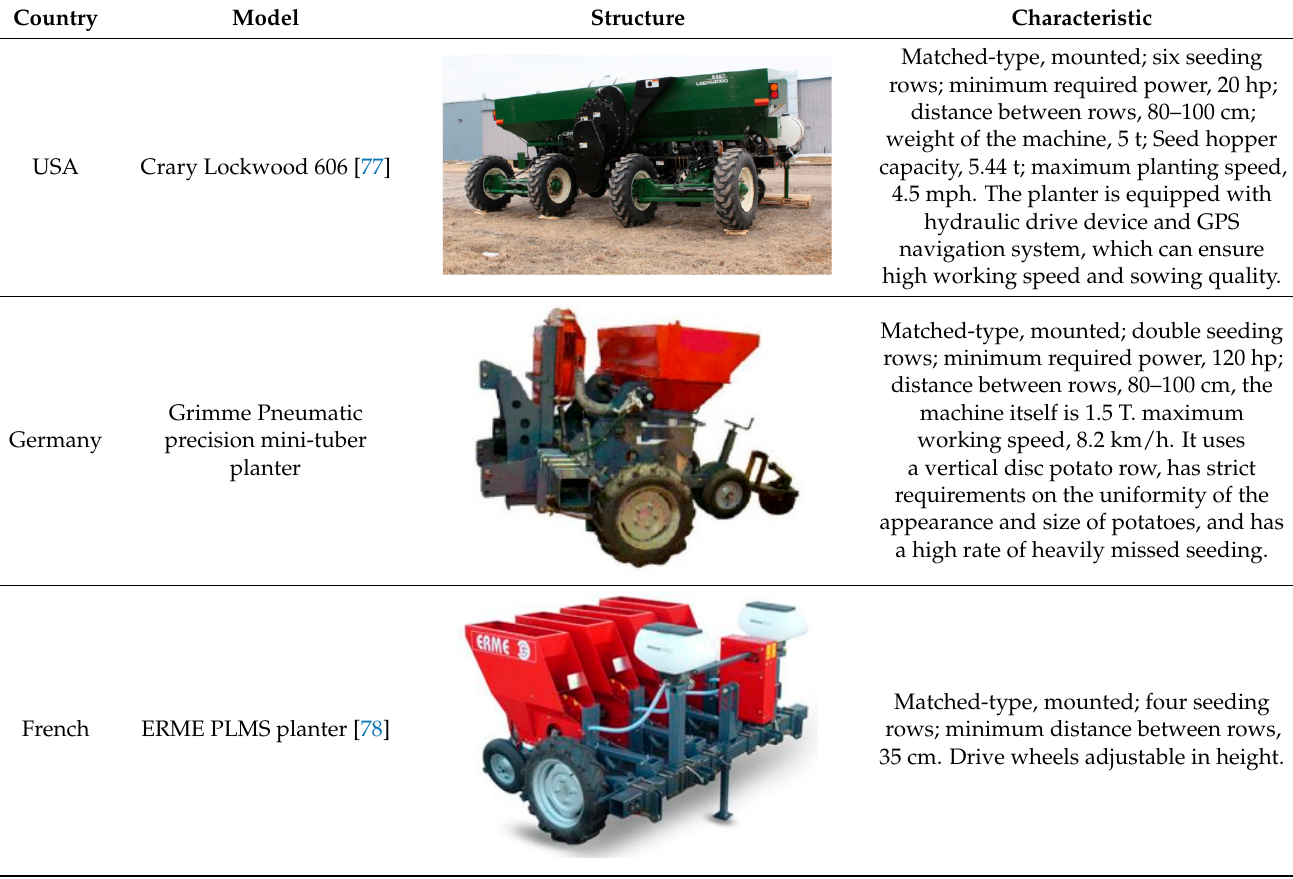
Table 6. Introduction of belt-type potato planters.